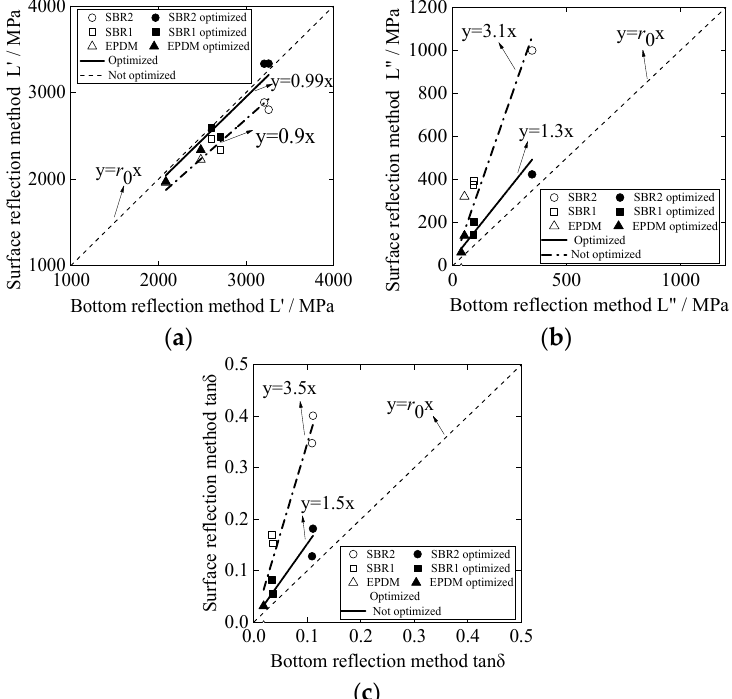
Figure 7. Linear approximation of the SRM and BRM simulation results for different kinds of rubber materials: ( a ) analysis of storage modulus L (cid:4593) results; ( b ) analysis of loss modulus L (cid:4593)(cid:4593) results; ( c ) analysis of loss tangent tan δ results.